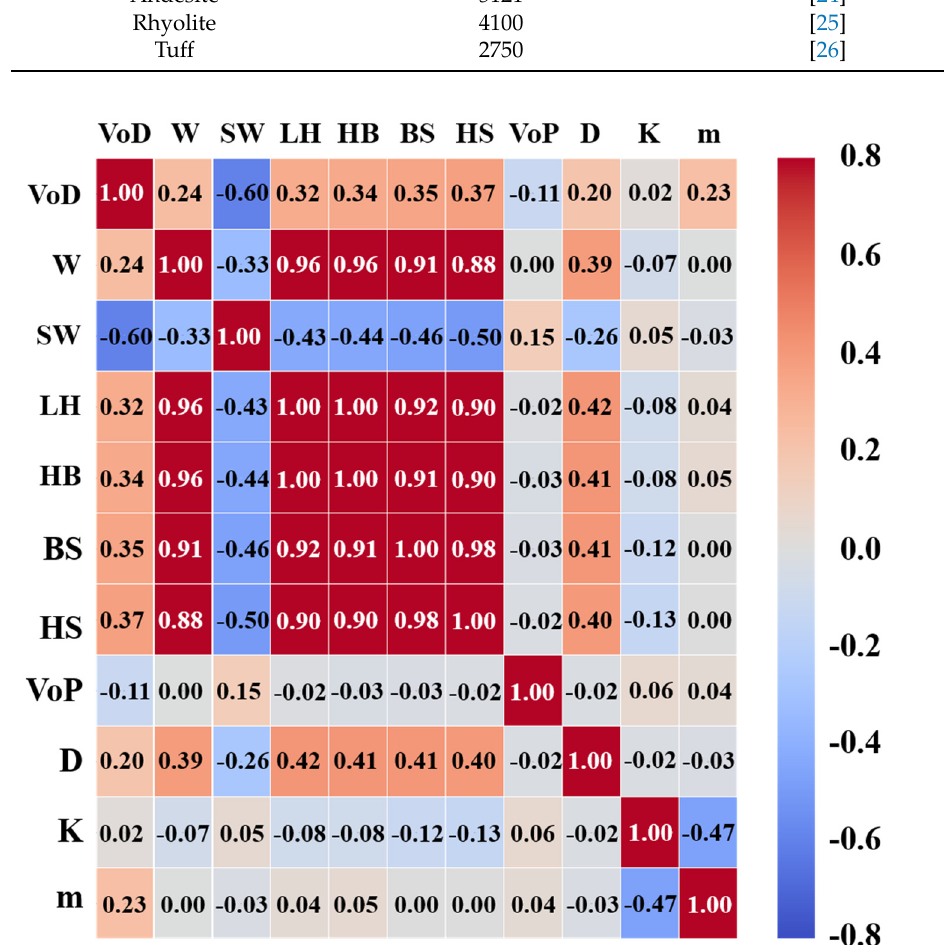
Figure 3. Correlations between initial influential factors. Table 1. Input values for types of explosive. Table 3. Characteristics of influential factors and peak particle velocity